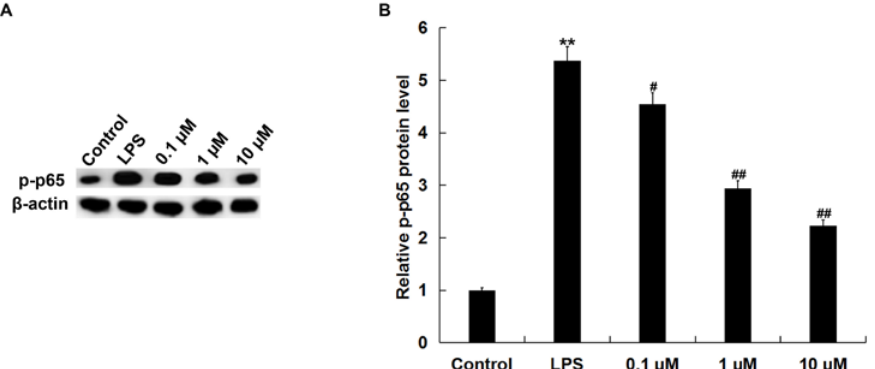
Figure 4: Effects of NGR1 on phosphorylation of NF-κB/p65 protein expression in LPS-treated RAW264.7 cells. In addition to an untreated control sample, RAW264.7 cells were pretreated with various concentrations of NGR1 (0.1, 1, and 10 µ M) for 2 h and then treated with 1 µ g/ml LPS at 37˚C for 24 h. A: the protein level of p-p65 was detected using western blotting; B: the relative protein level of p-p65 was analyzed and presented as the fold of the control. Data were expressed as the mean ± SD. **p<0.01 vs. control group; #, ## p<0.05, 0.01, vs. LPS treatment alone group.